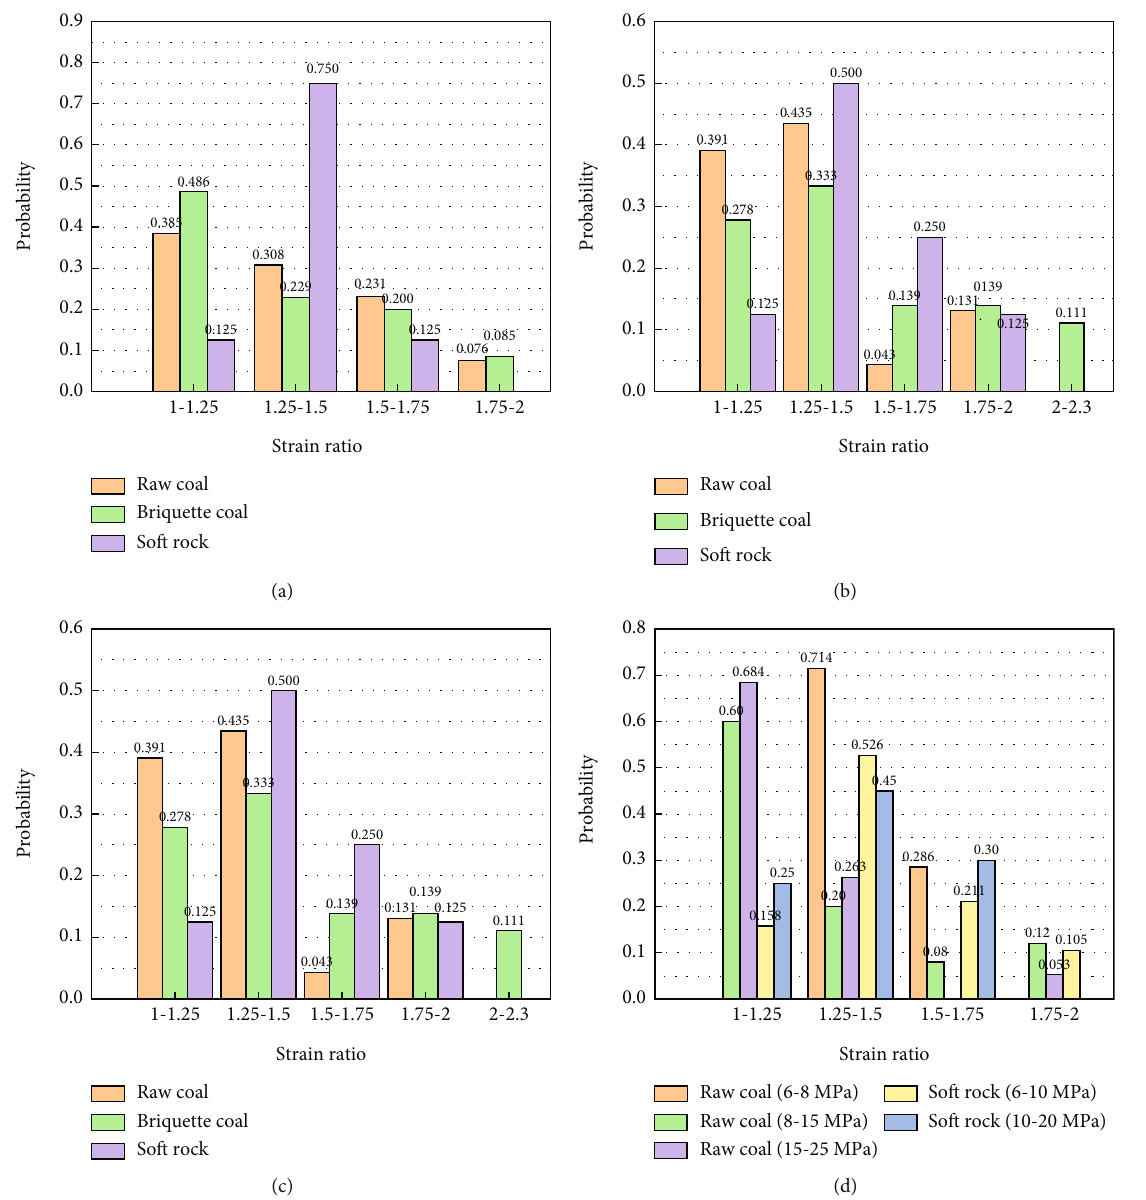
Figure 11: Probability analysis of equivalent residual strain ratio interval under di ff erent con fi ning pressures: (a) 0-2 MPa, (b) 2-4 MPa, (c) 4-6 MPa, and (d) above 6